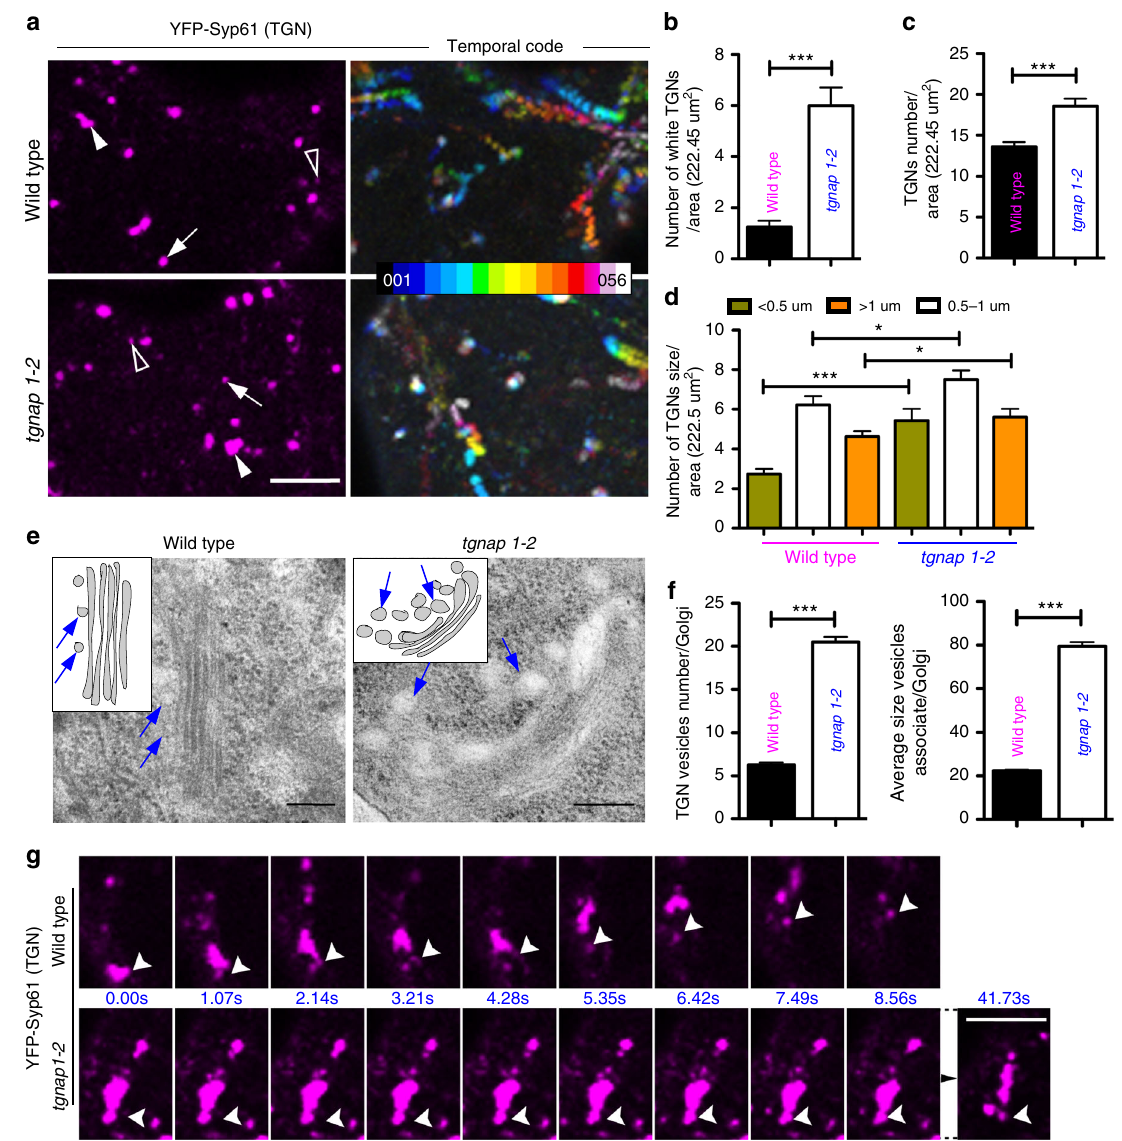
Fig. 7 Streaming and biogenesis of a TGNs subset requires TGNap1. a Confocal images of YFP-Syp61-positive TGNs in cotyledon epidermal cells of either WT or tgnap1 – 2 . Images are either single (left panels in magenta) or compound (right panels, color gradient images). In single images, arrowheads, arrows, and empty arrowheads indicate large, medium, and small TGNs, respectively. Compound panels are composite of 56 frames each pseudocolored along a color gradient (see scale) captured at 1.05 s interval. White color (last frame) overlapping other colors denotes slow mobility of the TGNs. Scale bar = 5 µ m. b Quanti fi cation of the number of YFP-Syp61 TGNs pseudocolored white in cotyledon epidermal cells of either WT or tgnap1 – 2 background (Student t -test was applied). c Quanti fi cation of the number of total YFP-Syp61 TGNs in cotyledon epidermal cells in WT and tgnap1 – 2 background, expressed as number of white TGNs/222.5 µ m 2 area ( n = 50 areas/genotype). d Size distribution of YFP-Syp61 TGNs in cotyledon epidermal cells of either WT or tgnap1 – 2 ( n = 50 areas/genotype) ( p -value calculated with one-way Anova with Tukey ’ s post test). e Transmission electron micrographs of Golgi and TGNs (arrows) in WT and tgnap1 – 2 roots. Insets: diagrams representing TGN-GA structures identi fi ed in the images. Scale bars = 0.2 µ m. f Quanti fi cation of number and size of GA-TGN vesicles/Golgi ( n = 60). Error bars: S.E.M. *** = p < 0.001 (Student t -test was applied, p -values are represented by asterisks when signi fi cantly different from the corresponding control). Number of Golgi analyzed = 60. g Frames from time-lapse microscopy (see Supplementary Movie 2A, B) of YFP-Syp61 labeled TGNs in cotyledon epidermal cells of WT and tgnap1 – 2 background showing GI-TGNs biogenesis (arrowheads) over time. Numbers between panels express the time (seconds). Note the delay of GI-TGN detachment in tgnap1 – 2 compared to WT. Scale bar = 1 µ m. Source data is provided as a Source Data fi